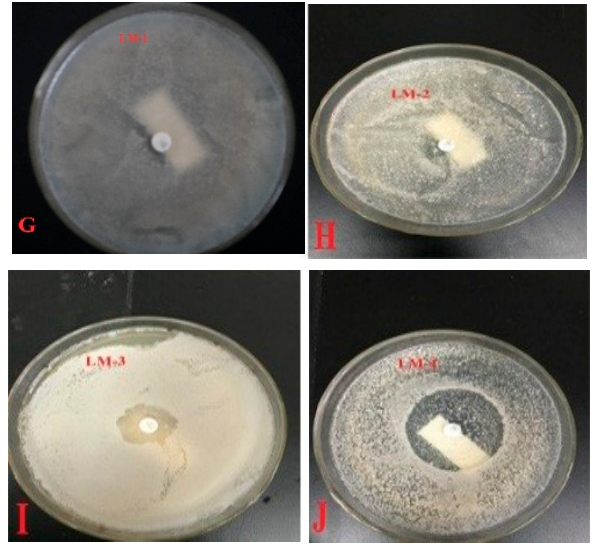
Figure 1. Results of penicillin V potassium (PVK) susceptibility test. G: LM-1; H: LM-2; I: LM-3; J: LM-4. To establish the standard curve, PVK solutions with concentrations of 0, 15, 30, 45, 60, 75, and 90 µ g / mL were prepared and the absorbance of PVK was measured at the maximum absorption wavelength (325 nm). Distilled water was used as the blank control (0 concentration). There was a good linear relationship between the PVK concentration and the absorbance value. The regression equation of the standard curve was determined to be Y = 0.006X − 0.001, with R 2 = 0.998, where Y